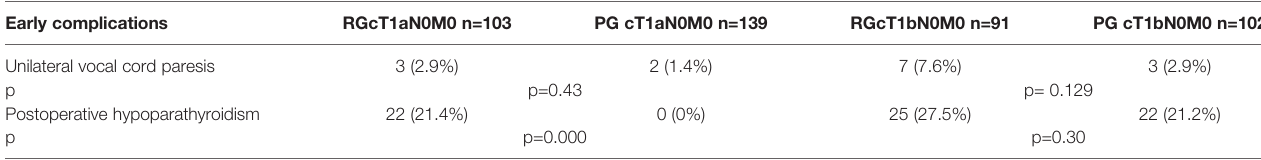
TABLE 6 | Comparison of the incidence of complications between patients undergoing TT with CND (RG group) and patients treated in the prospective study (PG). Early complications